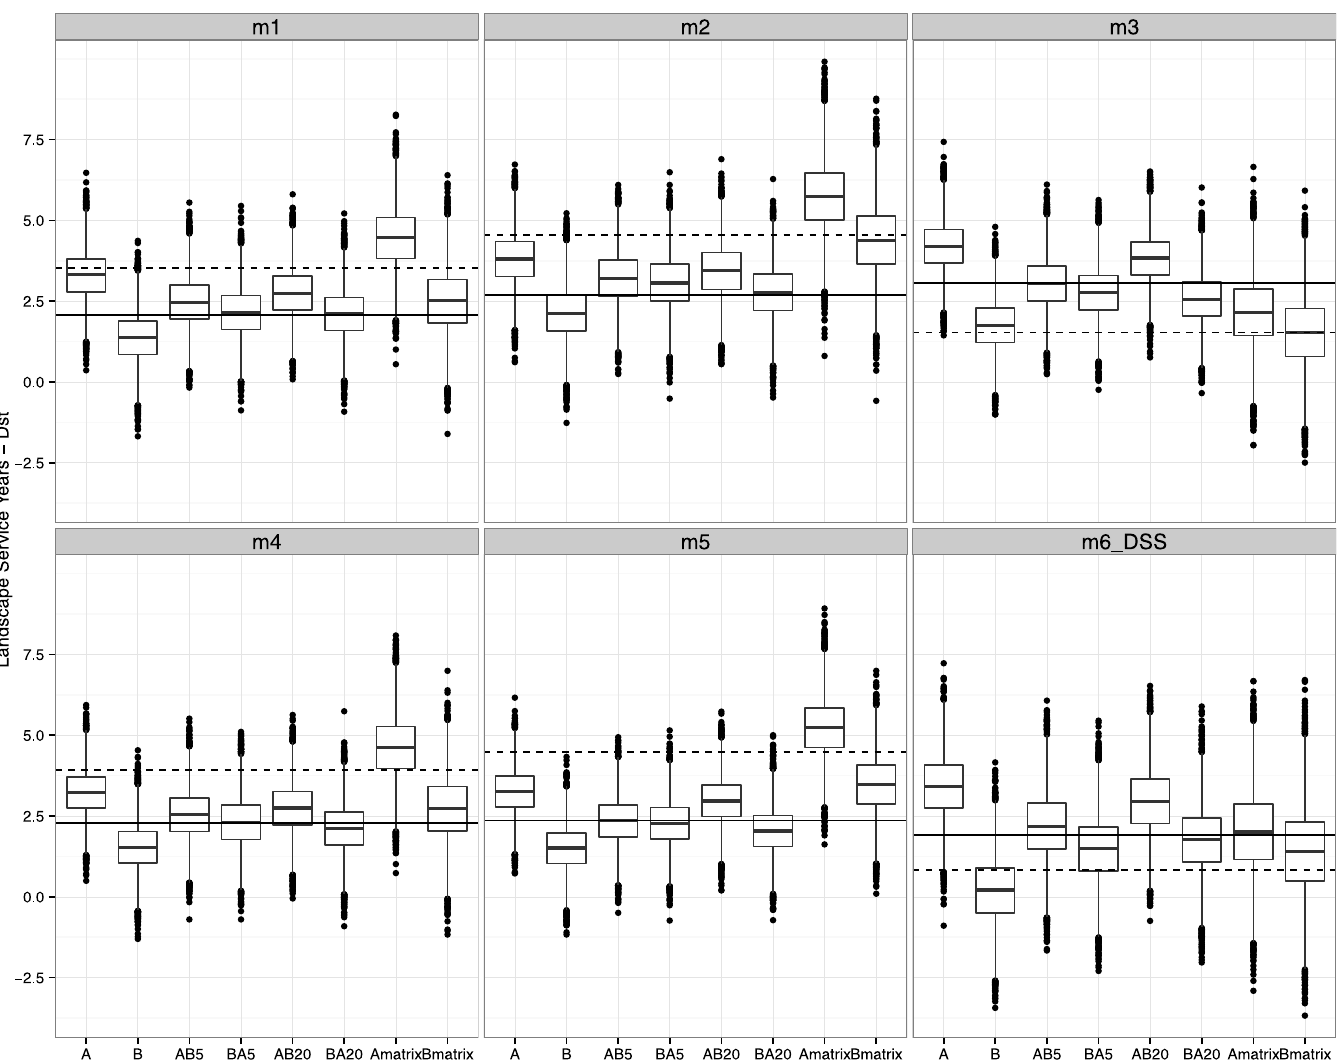
Fig 4. Landscape Service Years for average genetic divergence among breeding groups (Dst). Solid horizontal line represents the number of credits available in the bank, prior to a trade, assuming a static matrix and the dashed horizontal line is the number of credits available under a declining matrix. Boxplots of bootstrapped credit values remaining after each trade, with bars represent median values, the box represents the upper and lower 25 th quartile, whiskers represent max/min values excluding outliers, and dots represent outliers, or values 1.5 x 25 th